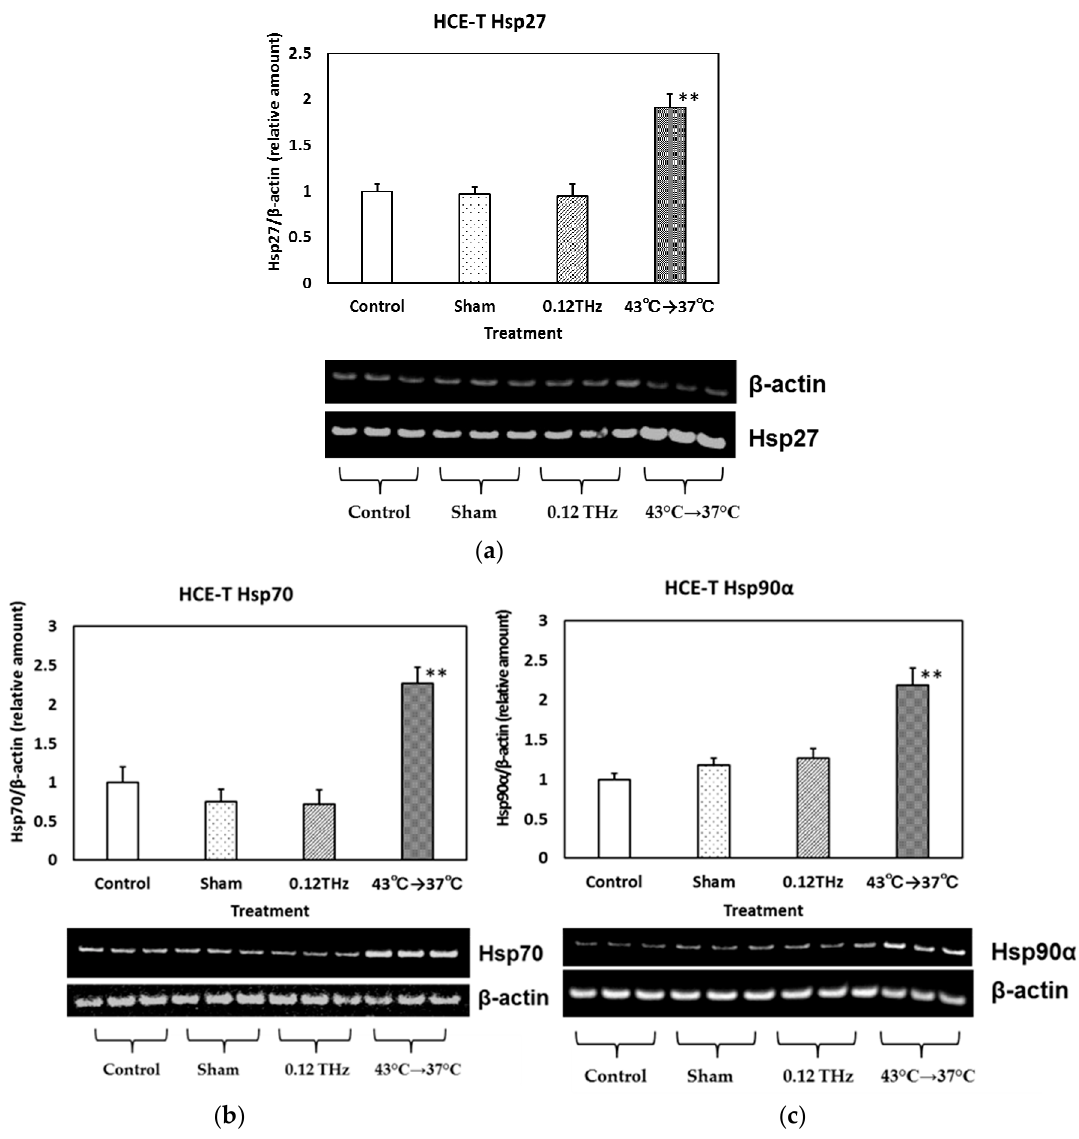
Figure 4. The expression levels of ( a ) heat shock protein 27 (Hsp27); ( b ) Hsp70; and ( c ) Hsp90 α in HCE-T cells exposed to 0.12 THz radiation for 24 h. The positive control comprised heat treatment at 43 °C for 0.5–2 h. Data are presented as the mean ± SD from three independent experiments. ** p < 0.01.